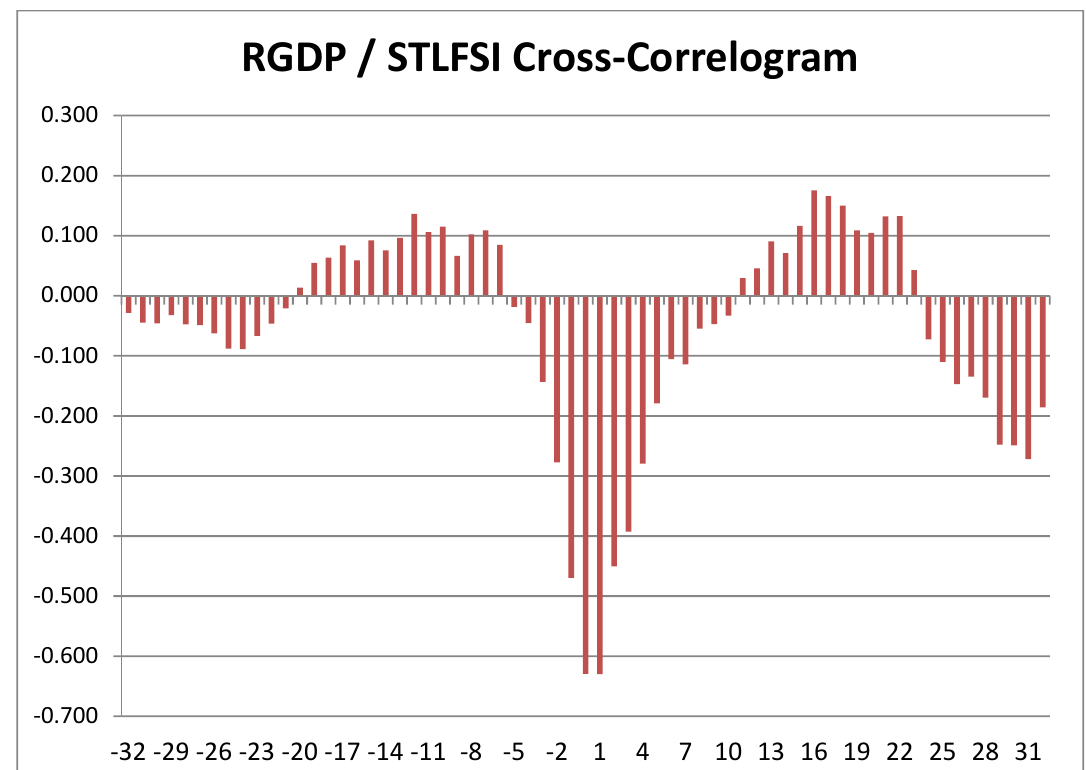
Figure 2. Cross-Correlogram with lags and leads on the x-axis. See Figure 1 caption for sample